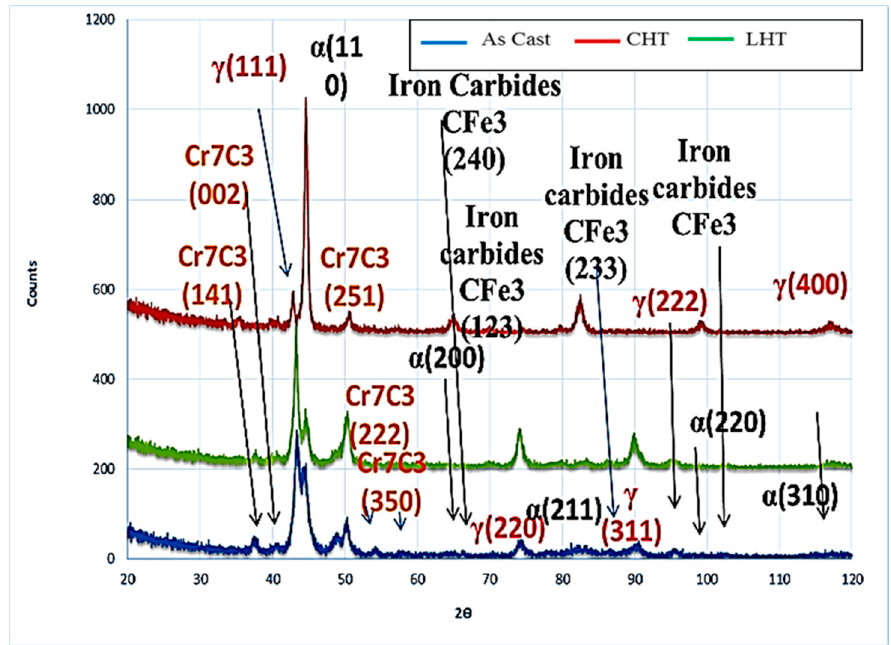
Figure10. Figure 10. XRD Pattern of the S2(Ni–hard 4) as-cast, conventionally heat-treated and laser-treated samples.